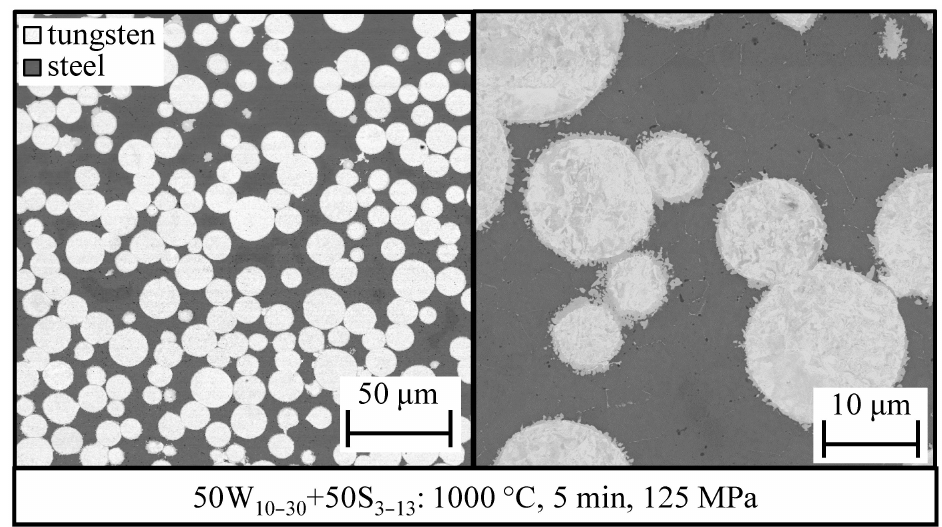
Figure 4. Cross-sectional SEM micrograph of 50 W composite sintered with optimized parameters (1000 ◦ C, 125 MPa, 5